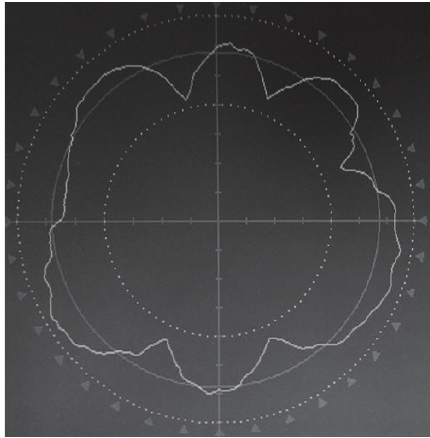
Figure 9: Out-of-roundness measurement results on premachined 34-CrNiMo6 steel. Ra0.45 and PV value 4.5 𝜇